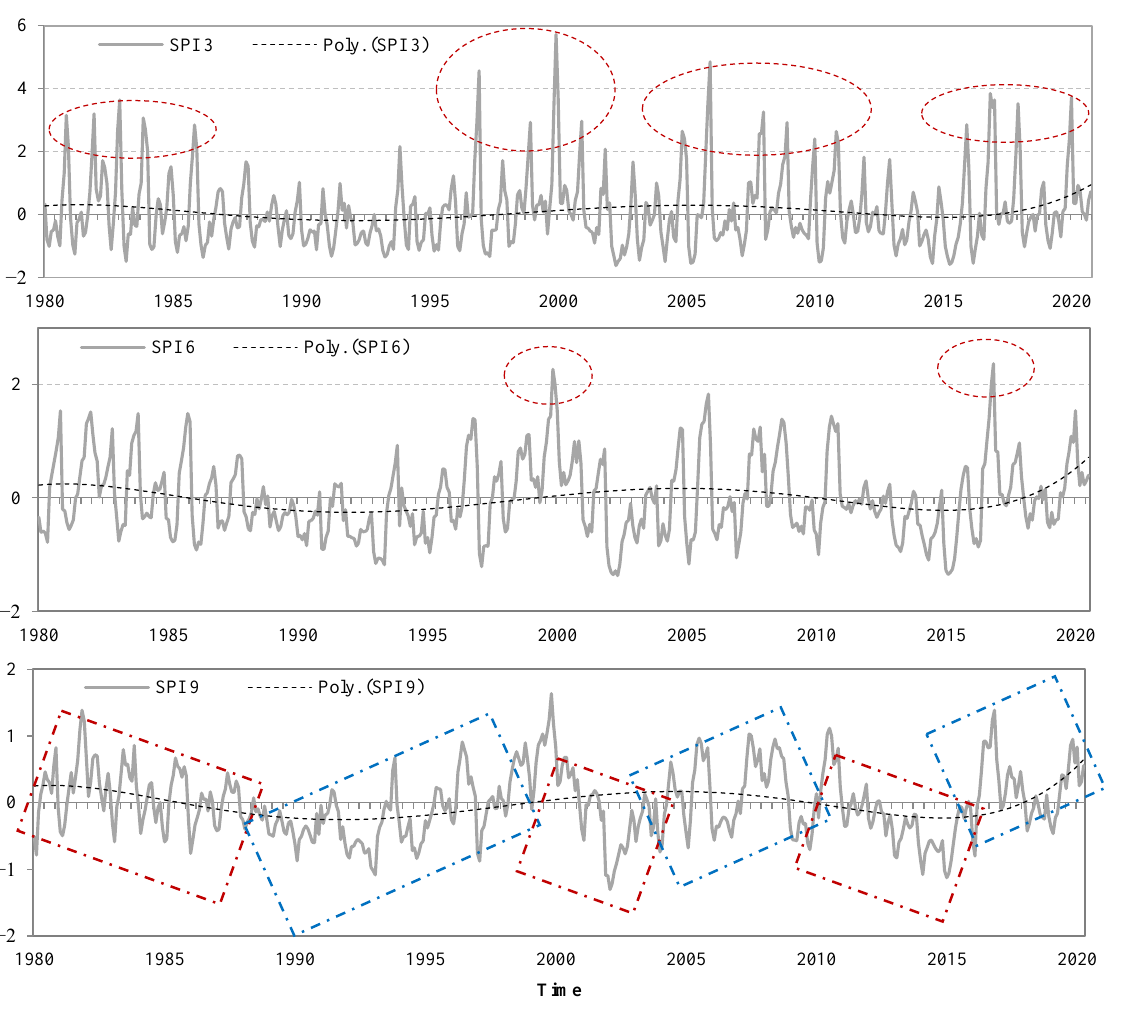
Figure 3. Drought time series at 3, 6, and 9 monthly SPI for the Chau Doc meteorological station. The best-fit lines using polynomial (Poly).